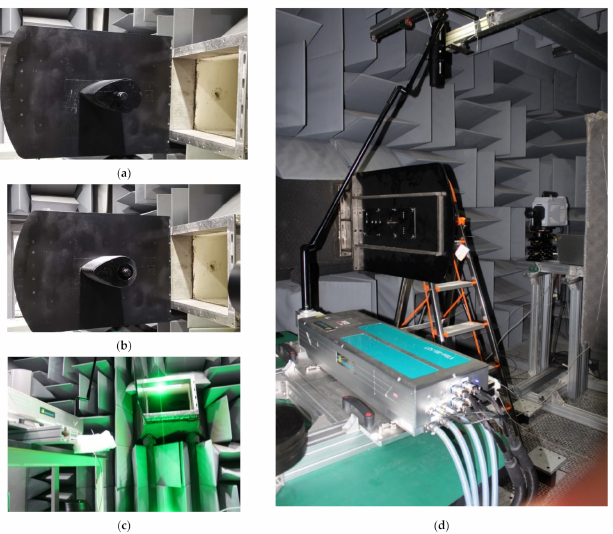
Figure 9. Experimental tests in wind tunnel: ( a ) scale model without rings; ( b ) scale model with rings; ( c ) test area under laser irradiation; ( d ) PIV camera and laser. Then, the streamlines and velocity fields behind the scale models were measured after the wind was applied. The measurement results are shown in Figure 10, where the dark blue areas on the right side of the figures are the trailing edge of the models. Since the laser illuminates from the bottom, the red areas in the figures are the shadow areas of the light path, in which the flow field data are